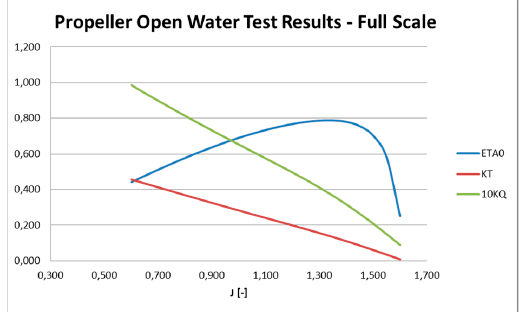
Figure 11. It reaches an efficiency of about 80% at a speed advance ratio J of about 1.40.